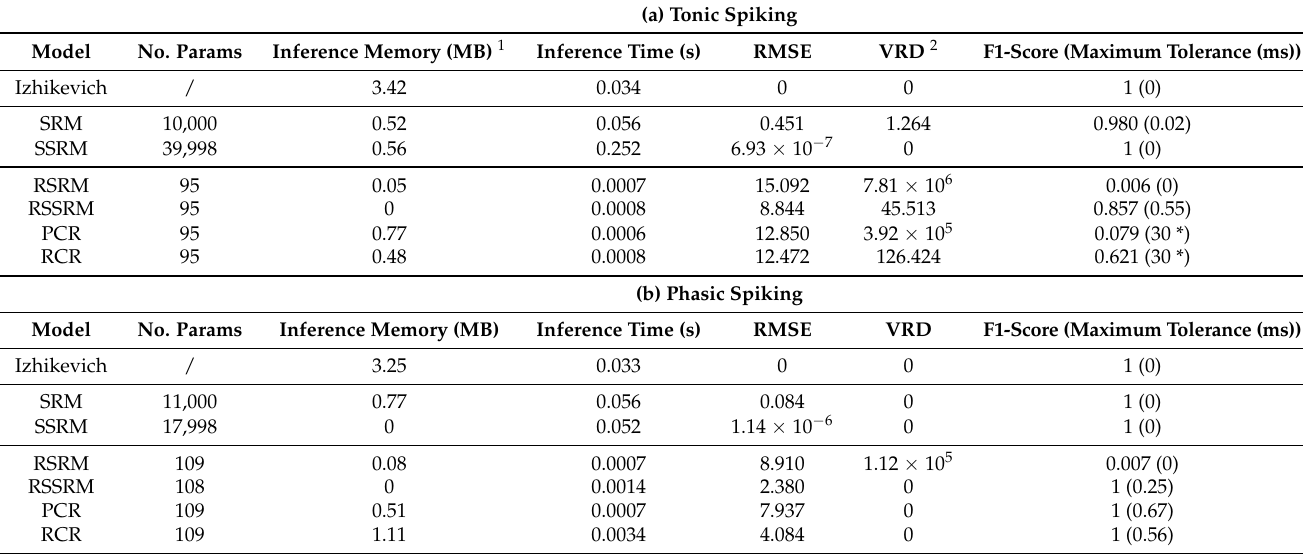
Table 2. The performance on twenty firing